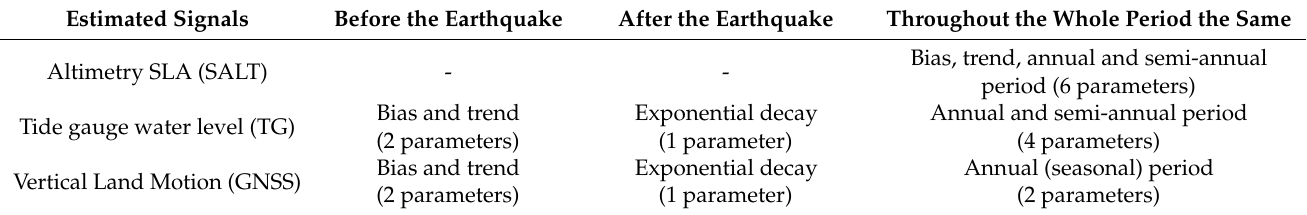
Table 2. Parameterization summary of the different sources and time periods that was applied to infer reliable trend estimates. The exponential decay function employs an exponential time constant τ of 40 years, corresponding to a half-life of approx. 28 years. This provided a good fit with the VLM given by the GNSS